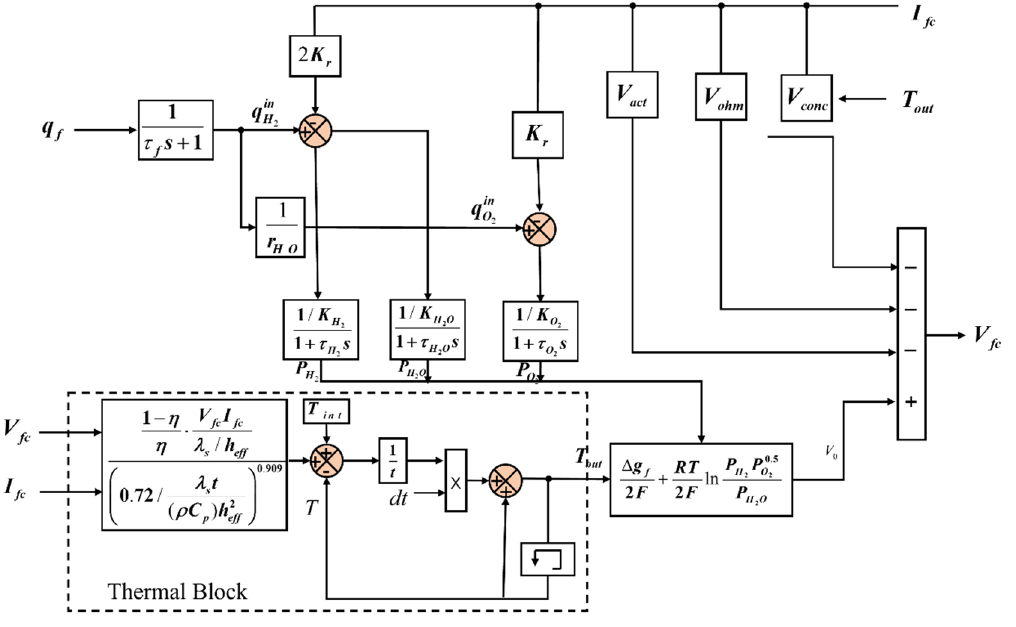
Figure 2. Partial model block diagram of SOFC system. Table 1. Meaning of involved SOFC system